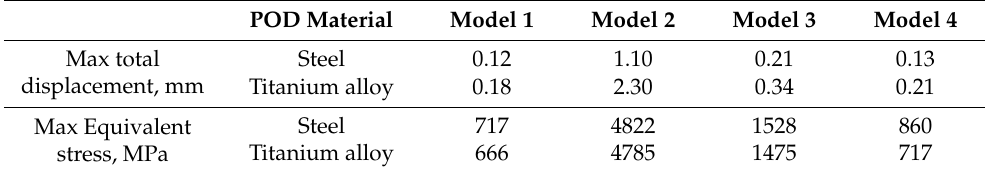
Table 2. Total displacement, equivalent stress highest values in POD, and mini-implants.